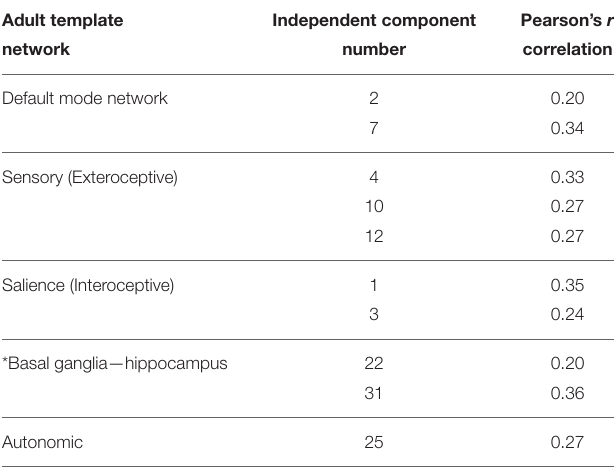
TABLE 1 | Components comprising resting-state networks of 2-week old rat in relation to previously described adult rat